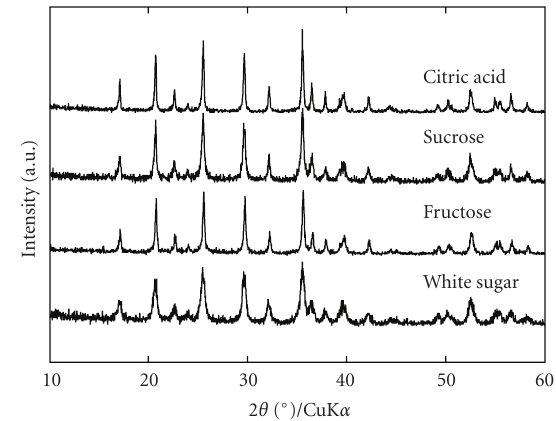
Figure 4: XRD patterns of LiFePO 4 /C powders calcined at 700 ◦ Cfor 2hours under argon (95%)/hydrogen (5%) atmosphere.